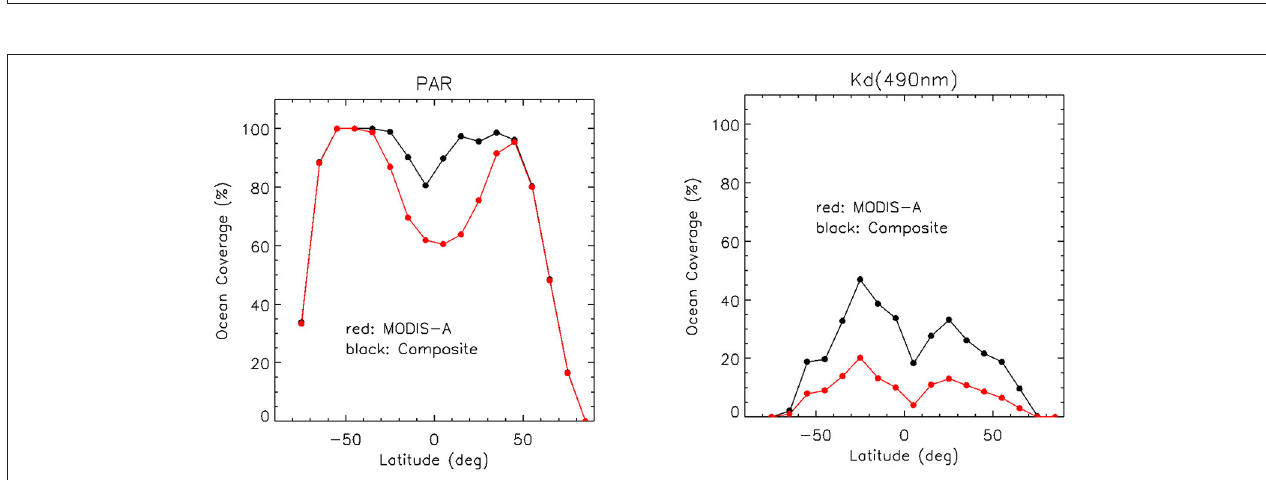
FIGURE 4 | Percentage of the ocean surface covered by (Left) PAR, (Middle) K d , and (Right) noon irradiance products on daily, weekly, and monthly time scales, i.e., March 22, March 22–29, and March 1–31, 2010. Situation is dramatic for K d , which is only retrieved in clear-sky conditions ( < 15% coverage at most latitudes).